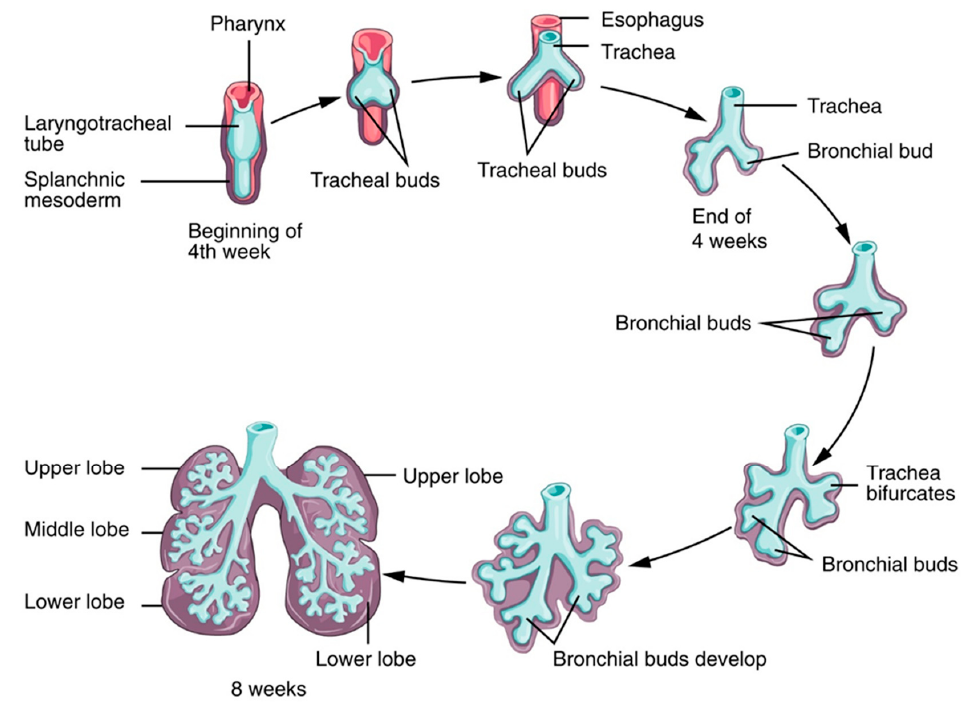
Figure 3. Lung development. Source: Anatomy and Physiology by Rice University, licensed under